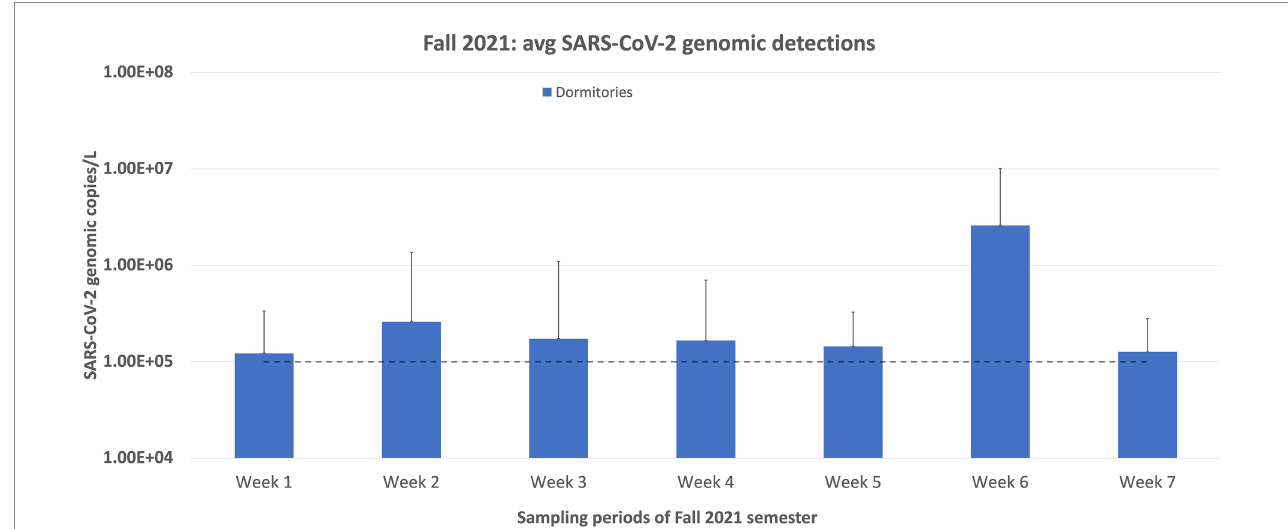
FIGURE 5 Weekly sampling results for the Fall semester of 2021. This sampling period was deemed necessary due to the rise of the Delta variant, which caused an increase in positive cases following the summer of 2021. During this time, only the dormitories were sampled and not the Greek village because all incoming first-year students were required to live in the dormitories, and most students in the Greek village should have been vaccinated by the Fall of 2021. Therefore, we estimated that the sampling results for the Greek village would be low to non-detectable. Also, students were not required to submit saliva samples for testing during this semester, which is why the active cases are not plotted here. The dashed line represents the limit of quantification for the N1 RT-qPCR assay. Any positive samples deemed “below quantifiable levels” are listed at 10 copies/ μ L. The error bars represent the maximum range of the positive sample concentrations above the